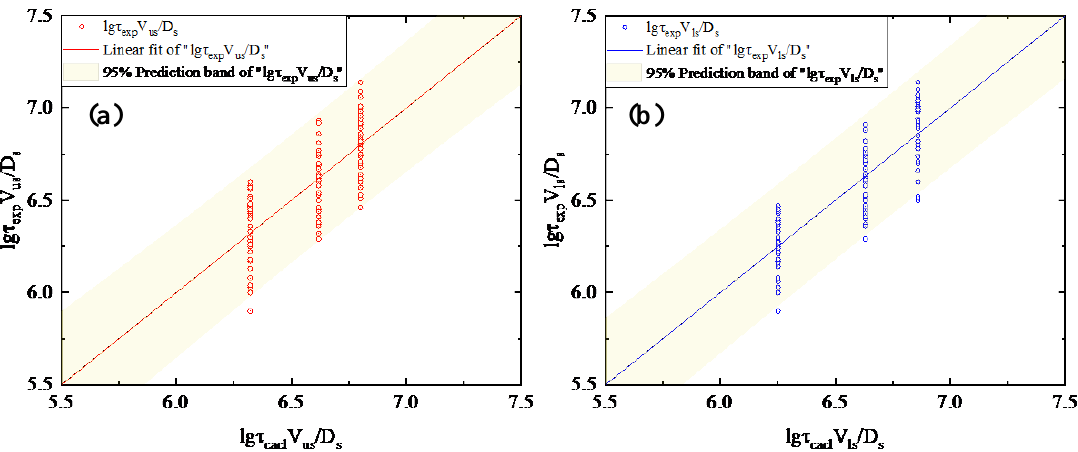
Figure 5. Comparison of experimental lg τV s / D s with calculated ones for upper side nozzle ( a ) and lower side nozzle ( b ), respectively, using proposed Equations (15) and (16).